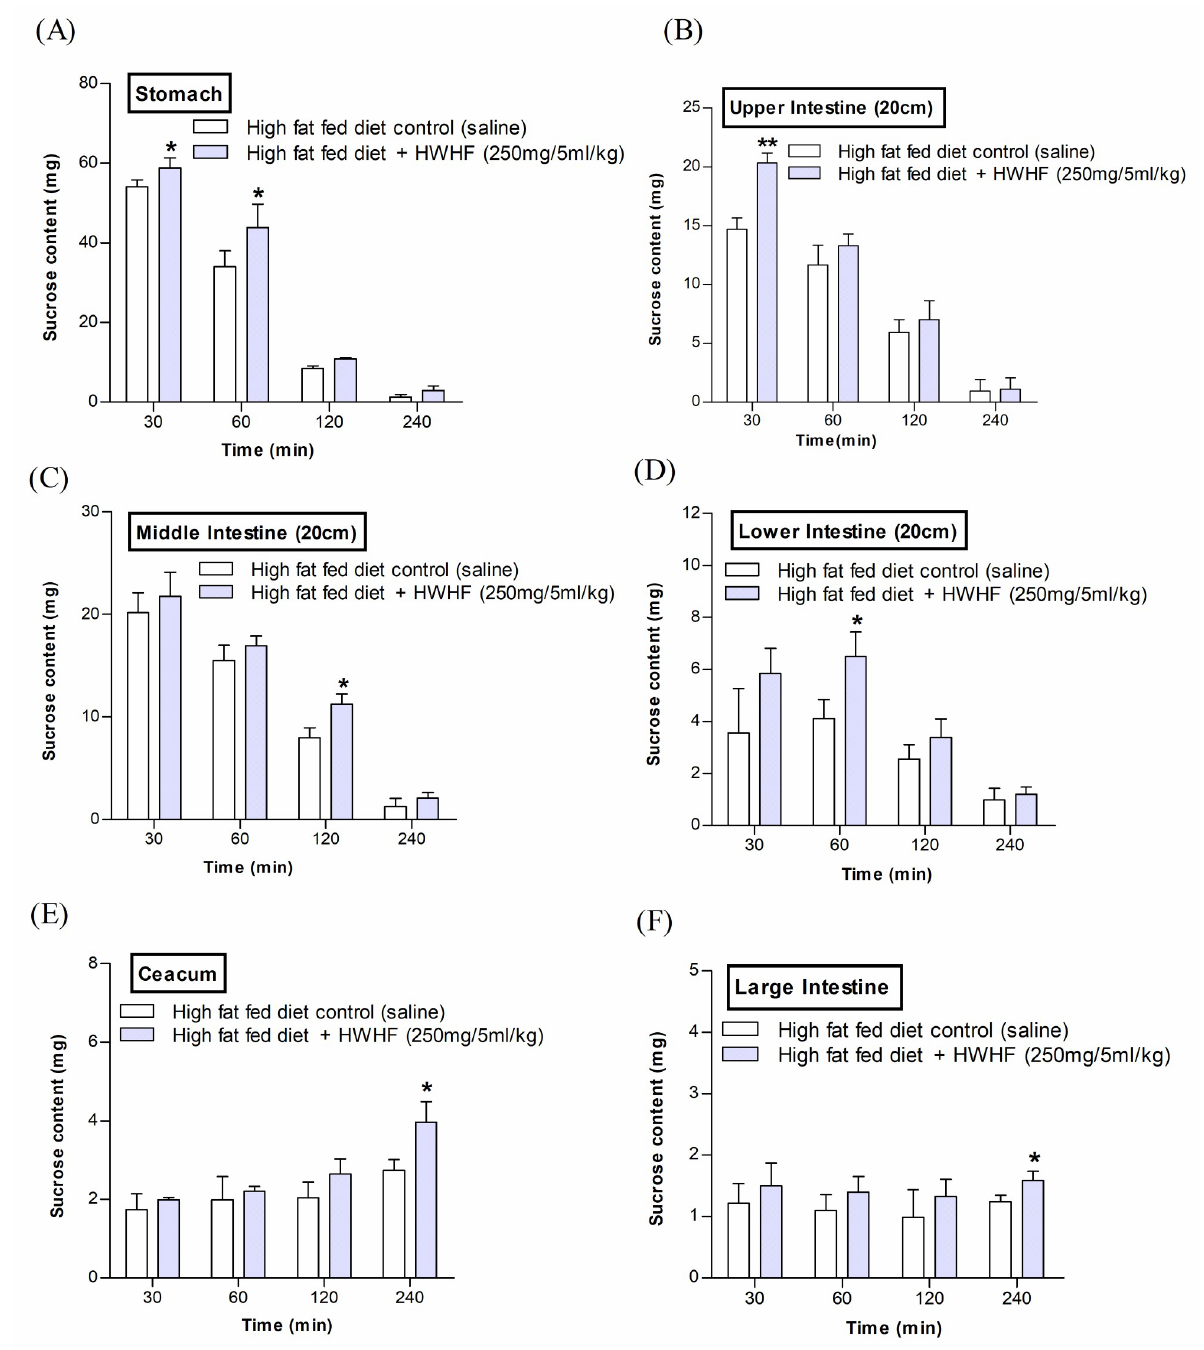
Fig 4. Effects of HWHF on (A-F) sucrose content in the gut after oral sucrose loading in high fat fed rats. Rats were fasted for 24 h before the oral administration of sucrose solution (2.5 g/kg b.w.) with or without HWHF (250 mg/5ml/kg, b.w.). Values are Mean ± SEM, n = 6. � p < 0.05 and �� p < 0.01, compared to